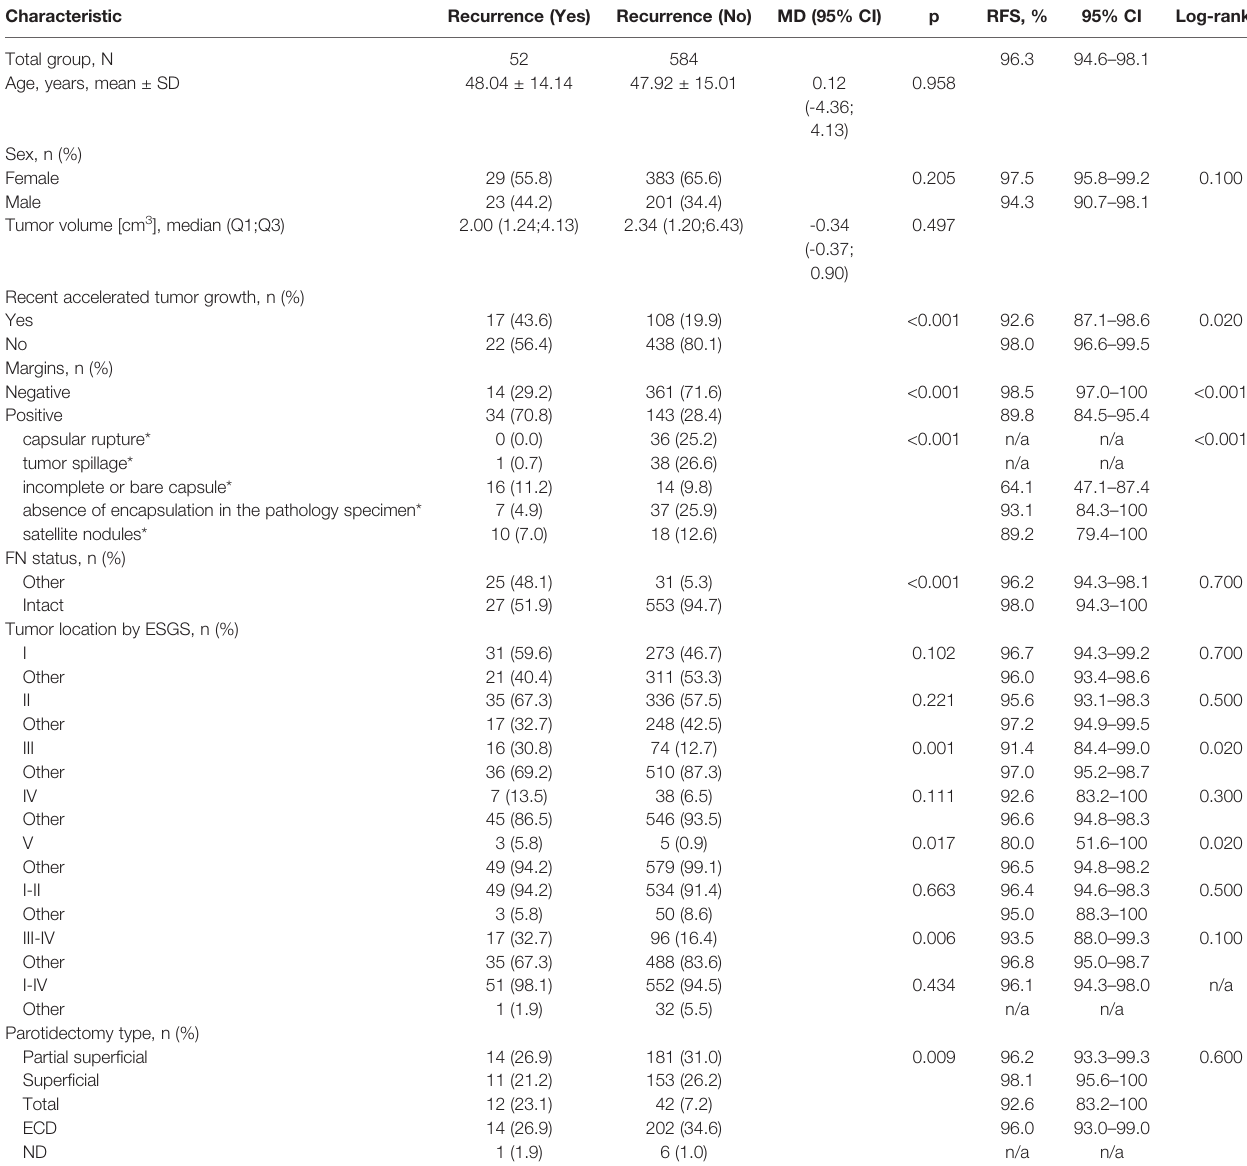
TABLE 4 | Comparison of features in r-PA versus